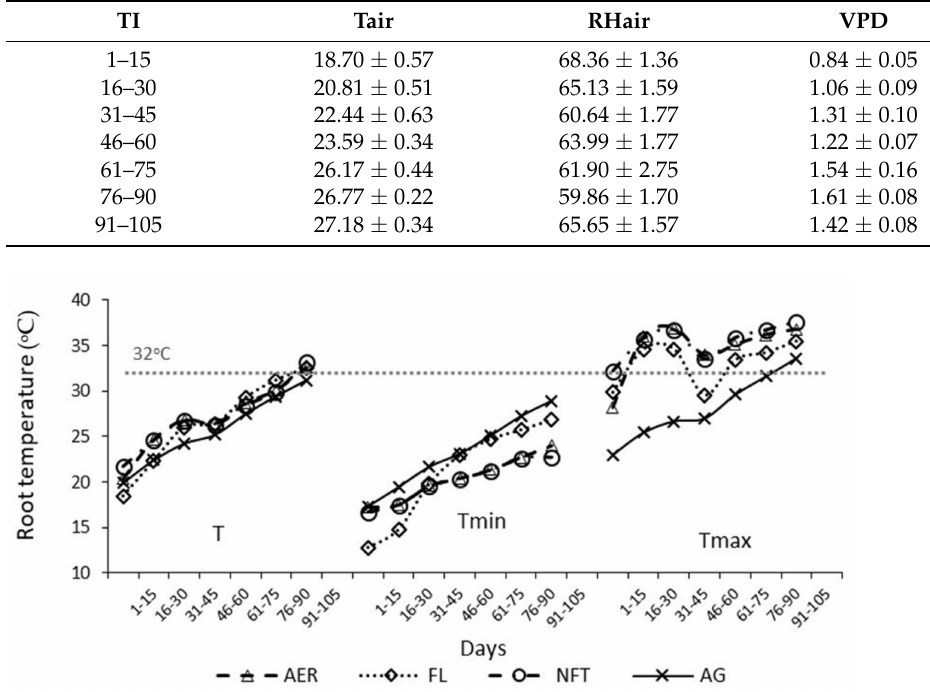
Table 3. Mean hourly values ( ± standard error) of greenhouse air temperature (Tair, ◦ C), greenhouse